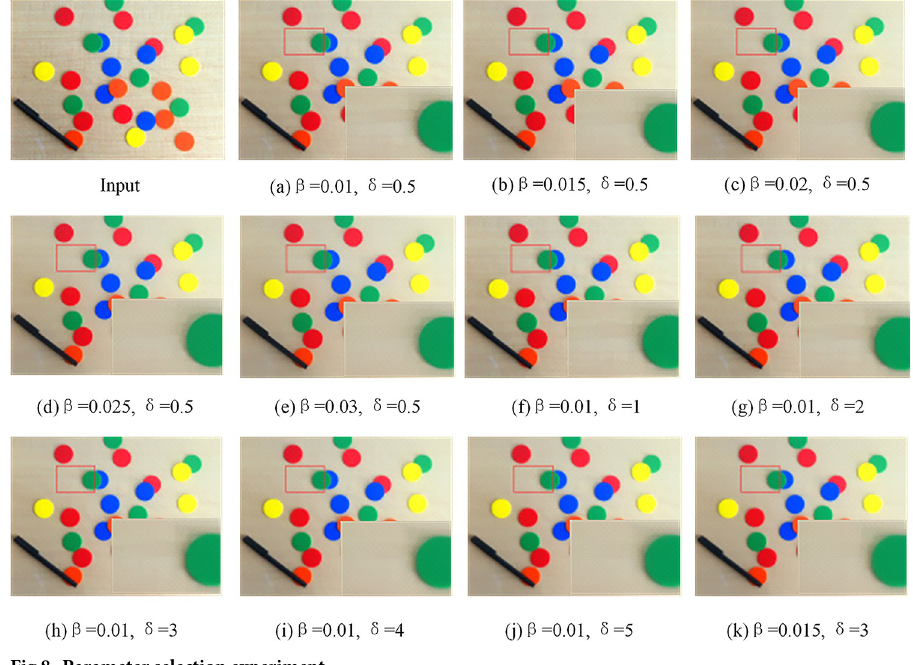
Fig 8. Parameter selection